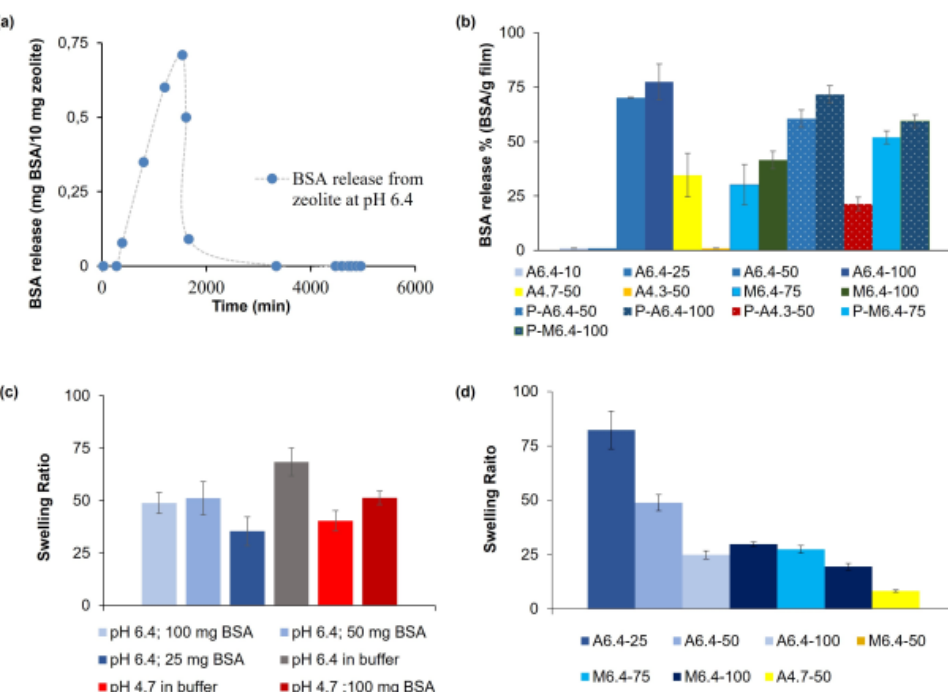
Figure 11. ( a ) BSA release from zeolite particles, ( b ) BSA release from pectin–zeolite and pectin hydrogels, ( c ) Swelling ratios of PZ-30 hydrogel films in different buffer solutions containing BSA molecules, ( d ) Equilibrium swelling ratios of hydrogels.